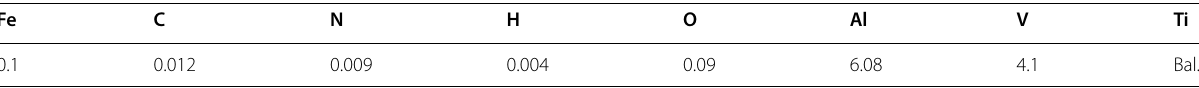
Table 1 Chemical composition of Ti-6Al-4V (wt.%)